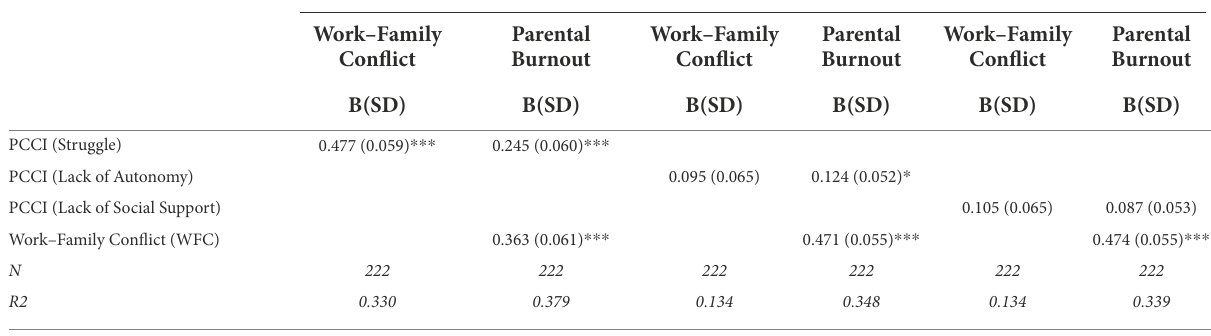
TABLE 4a Hayes mediation analysis on parental burnout (Y) with Work–Family Conflict (M) and PCCI (X; including all controls from the past Table, results not shown) at Time-1 (2021).